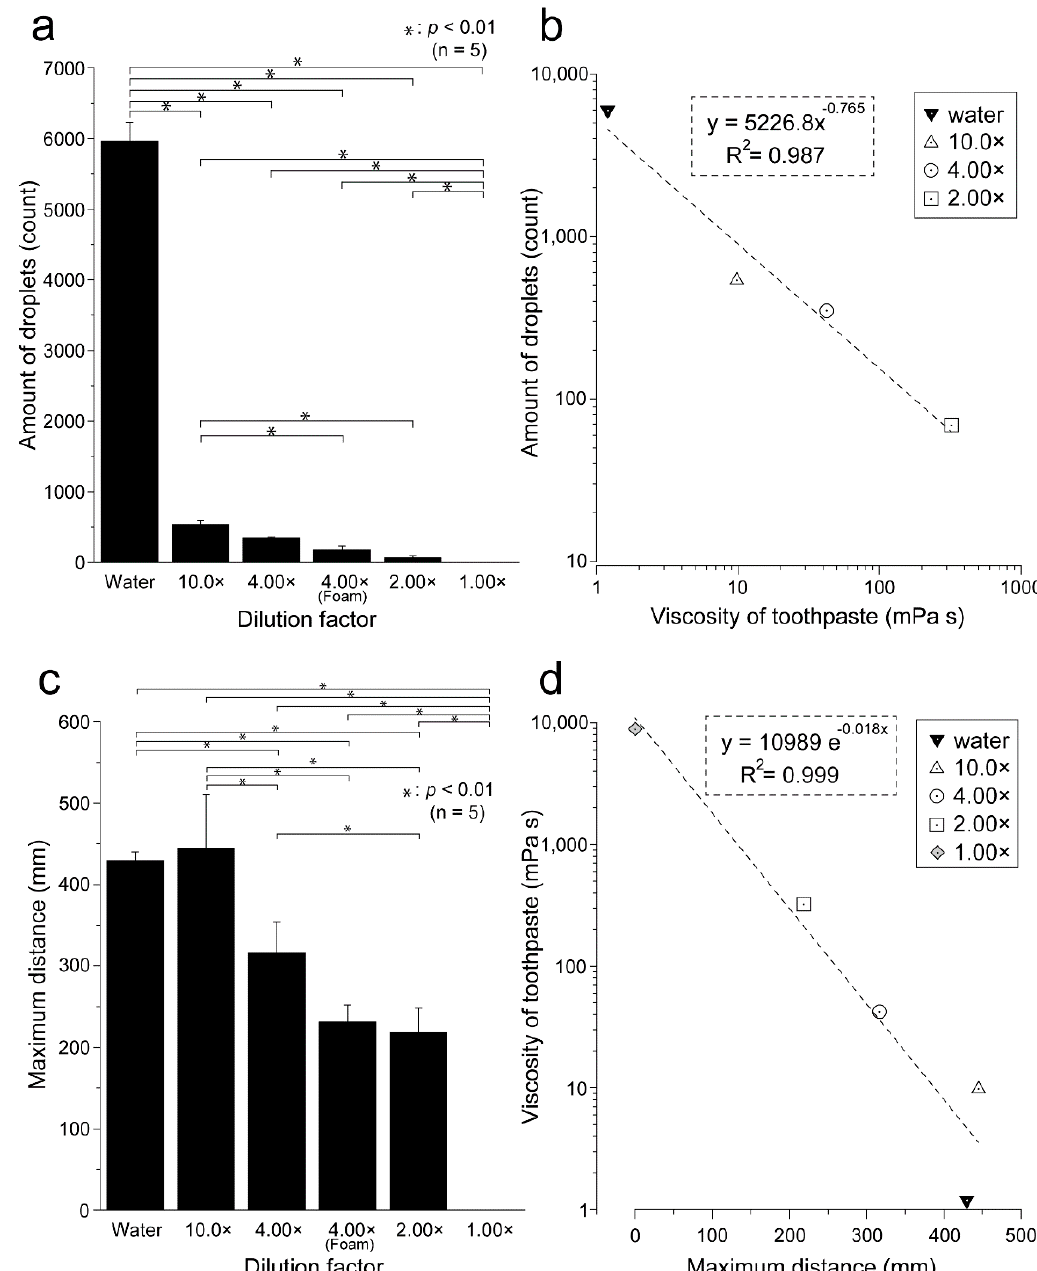
Figure 4. Comparison of the number of droplets generated and the maximum droplet distance by the toothpaste dilution ratio. ( a ) The relationship between the toothpaste dilution ratio and the number of droplets is shown. The number of droplets is presented as the mean ± standard deviation of five replicates per dilution ratio ( n = 5); ( b ) the concentration of each toothpaste dilution (2.00 × , 4.00 × , 10.0 × ), the viscosity of water, and the number of droplets is shown. The black inverted triangles indicated dentifrice with water. White triangles: 10% (10.0 × ); white circles: 25% (4.00 × ); white square: 50% (2.00 × ); gray diamonds: 100% (1.00 × ). A scatter plot was created with the logarithmic value of the number of droplets generated on the vertical axis and the logarithmic value of the viscosity on the horizontal axis. There was a strong negative correlation between toothpaste viscosity and the number of droplets generated ( r = − 0.993); ( c ) the relationship between the toothpaste dilution ratio and the maximum flight distance is shown; ( d ) there was a strong negative correlation between toothpaste viscosity and the number of droplets generated ( r = − 0.999).